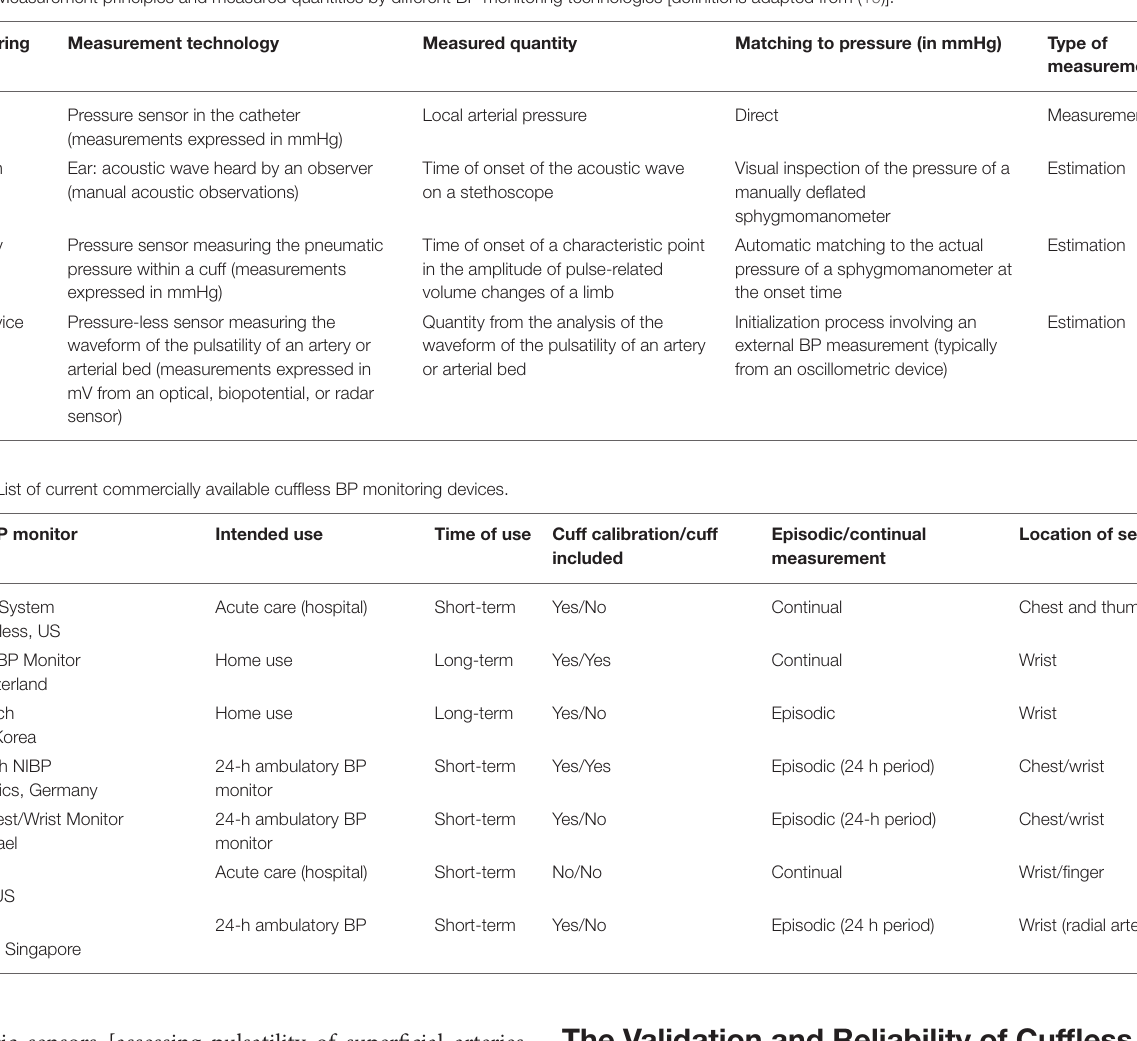
TABLE 1 | Measurement principles and measured quantities by different BP monitoring technologies [definitions adapted from (19)].